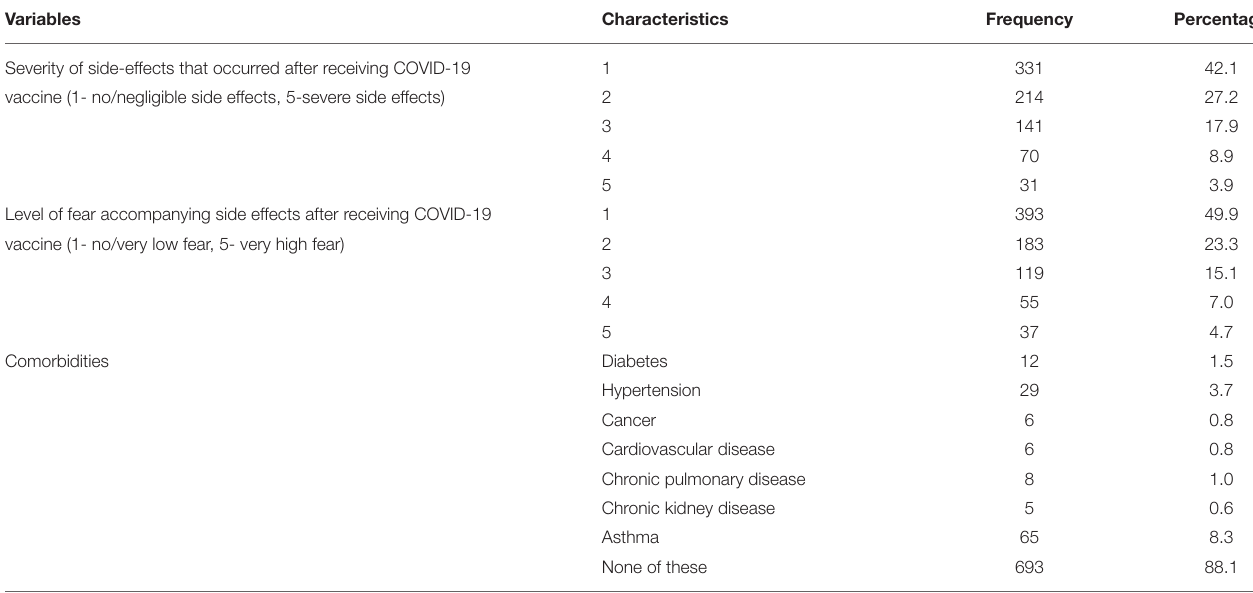
TABLE 2 | Characteristics of the respondents.